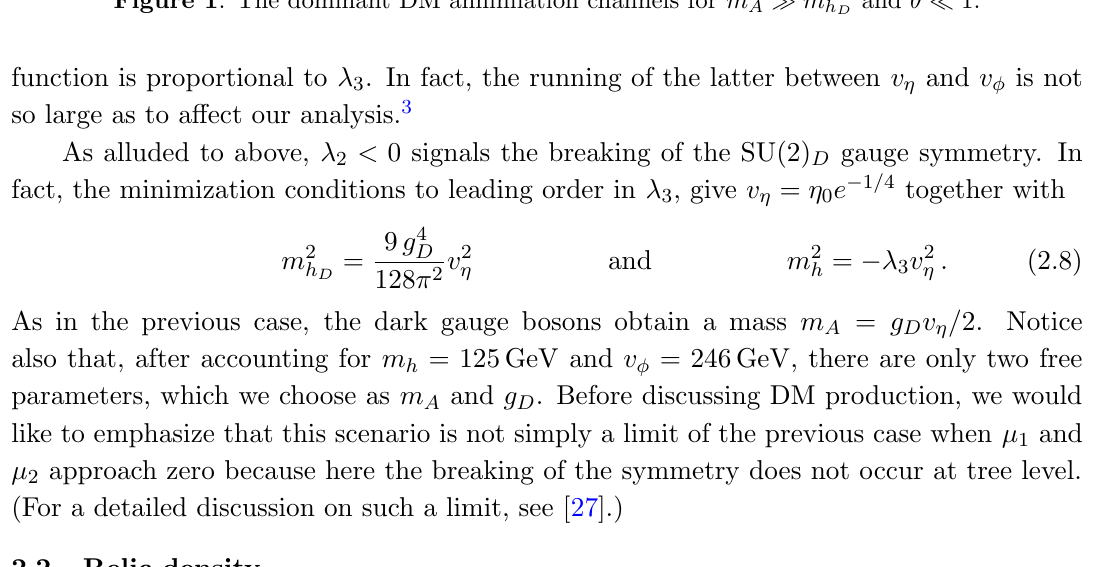
Figure 1 . The dominant DM annihilation channels for m A (cid:29) m h